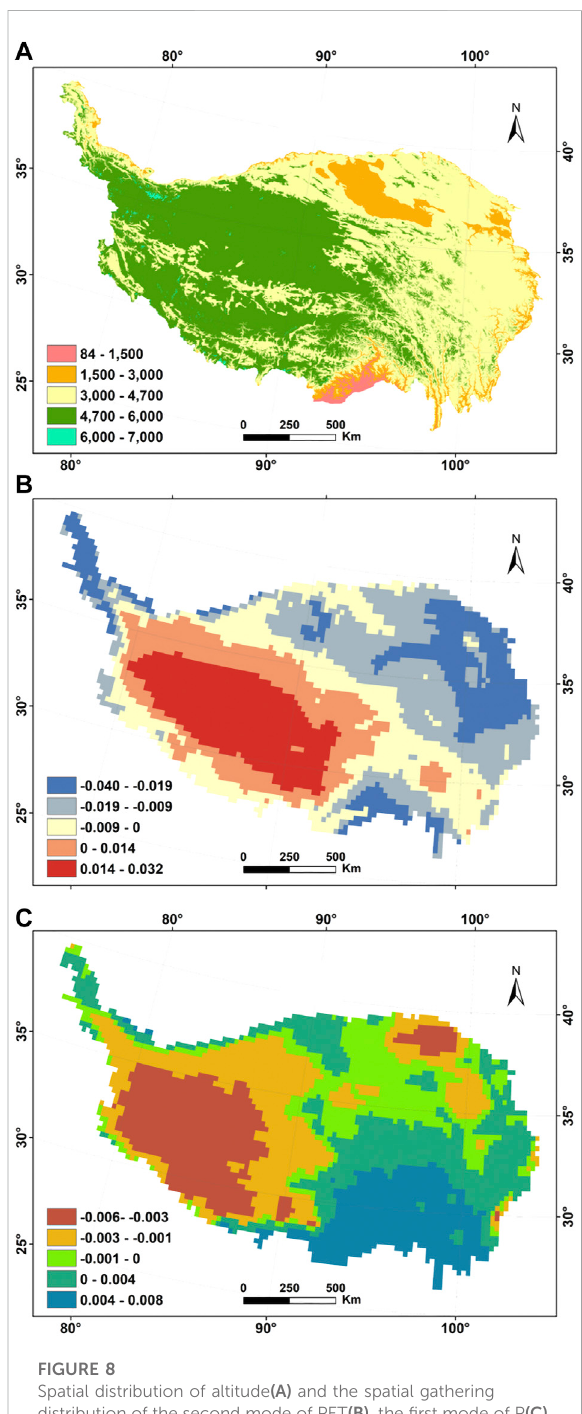
FIGURE 8 Spatial distribution of altitude (A) and the spatial gathering distribution of the second mode of PET (B) , the fi rst mode of P (C)